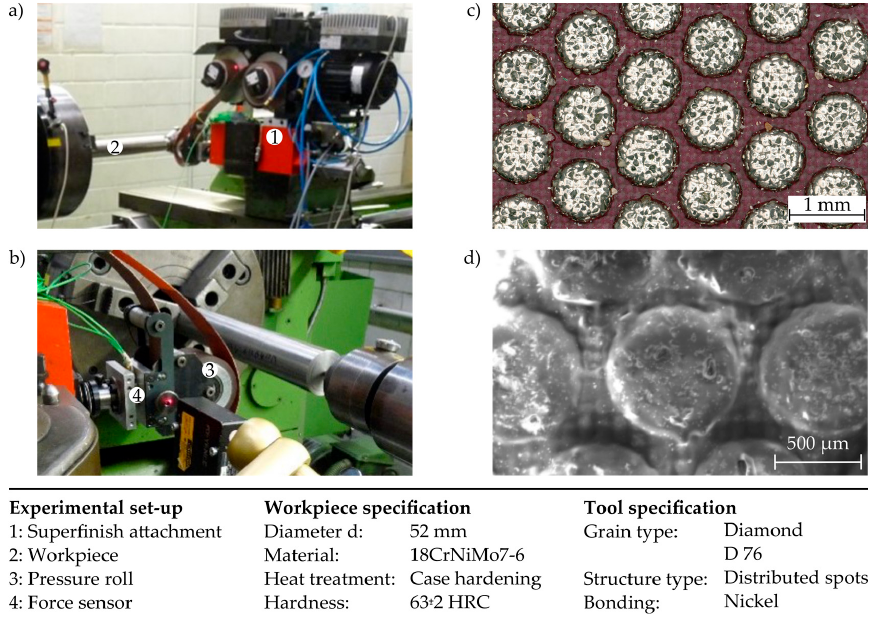
Figure 1. Process periphery. ( a , b ) Experimental set-up; defined abrasive belt; ( c ) microscopic image; ( d ) SEM-image.